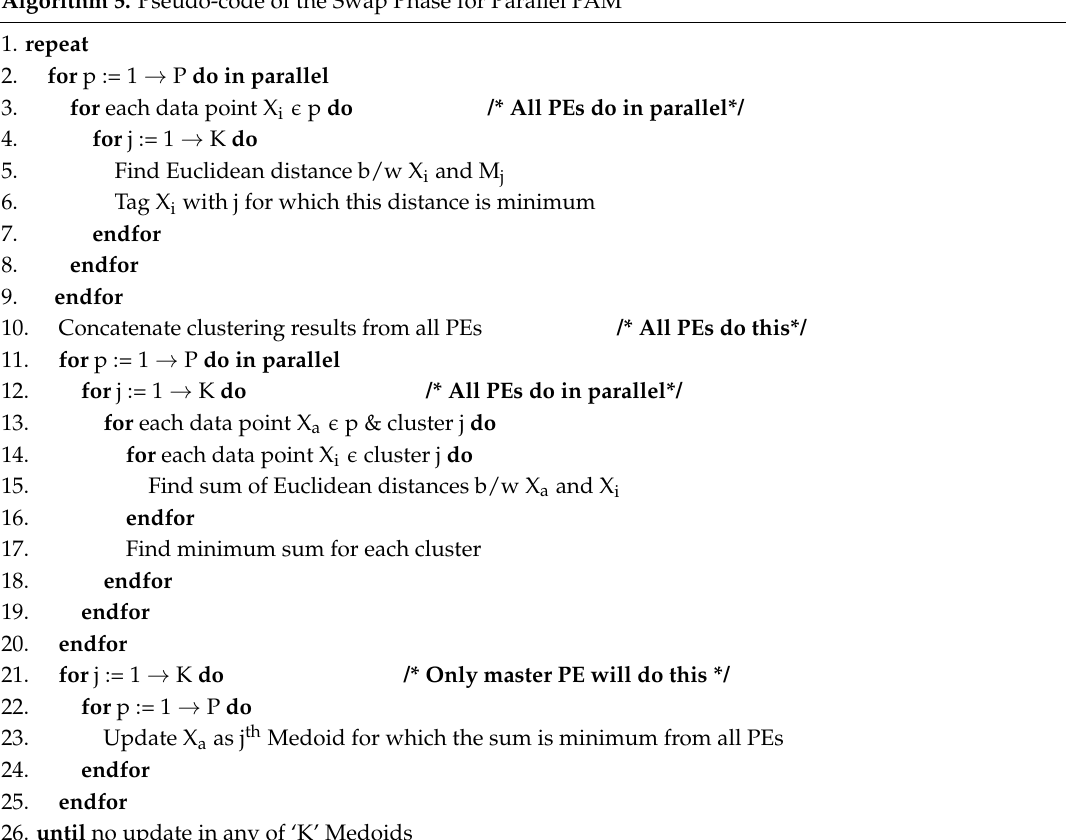
Algorithm 5. Pseudo-code of the Swap Phase for Parallel